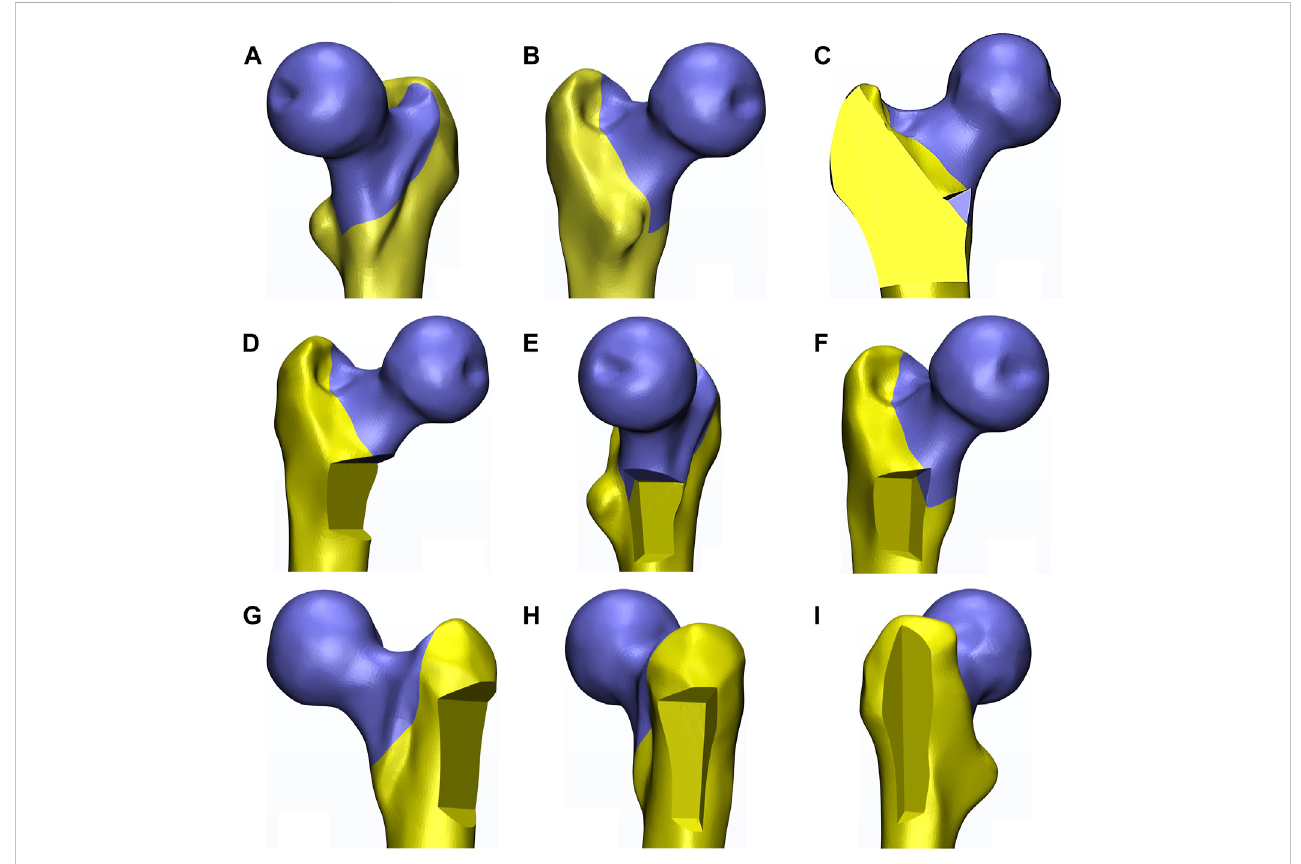
FIGURE 1 Thediagramexhibitedtheconstructedeightfracturemodelsbasedononeleftfemur(alsothefollowing fi gures). (A,B) indicateddifferentperspectivesof the basic fracture model. (C – I) indicated the posterior coronal bone defect model, the medial, the anteromedial, the posteromedial, the lateral, the anterolateral, and the posterolateral wall defect model,